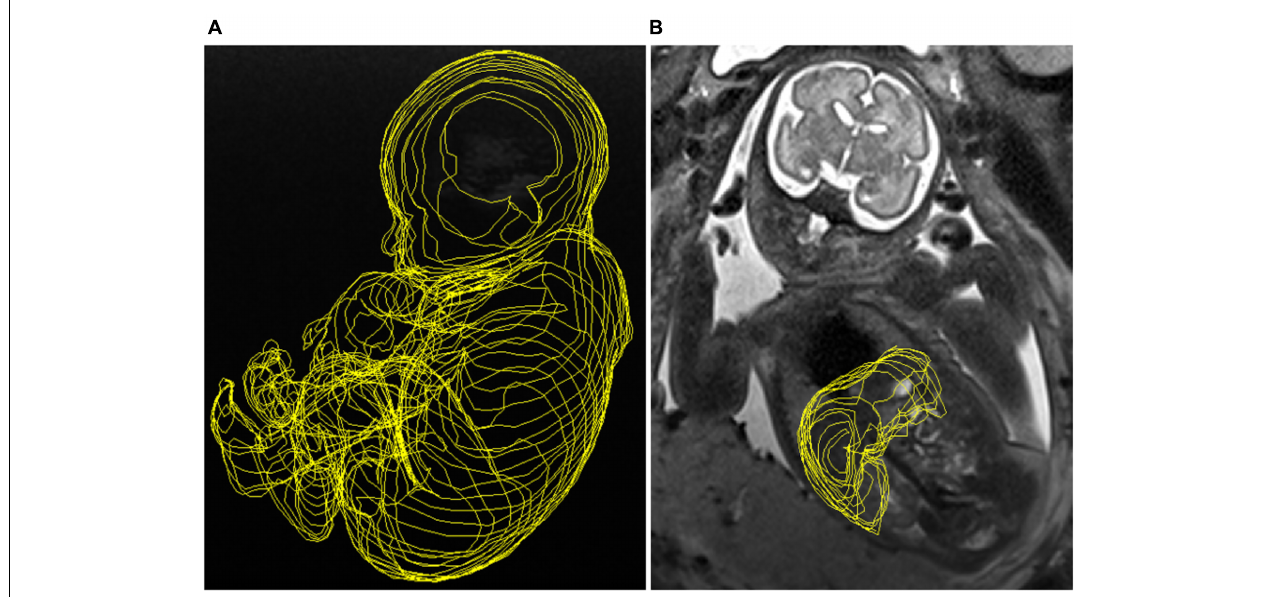
FIGURE 1 | (A) Manual tracing of the total fetal body obtained from a T2-weighted imaging sequence in sagittal view. (B) Manual tracing image of the fetal liver volume obtained from a T2-weighted imaging sequence in coronal